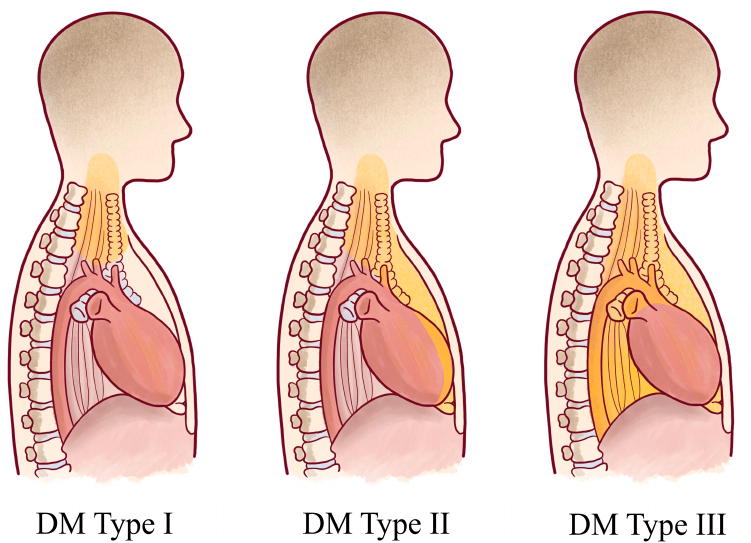
Figure 4. Descending mediastinitis (DM) classifications. The grey area indicates the extension of infections. Type I: DM is localized in the upper mediastinum above the tracheal bifurcation. Type II: DM extends to the lower anterior mediastinum. Type III: DM extends to the anterior and lower posterior mediastinum.